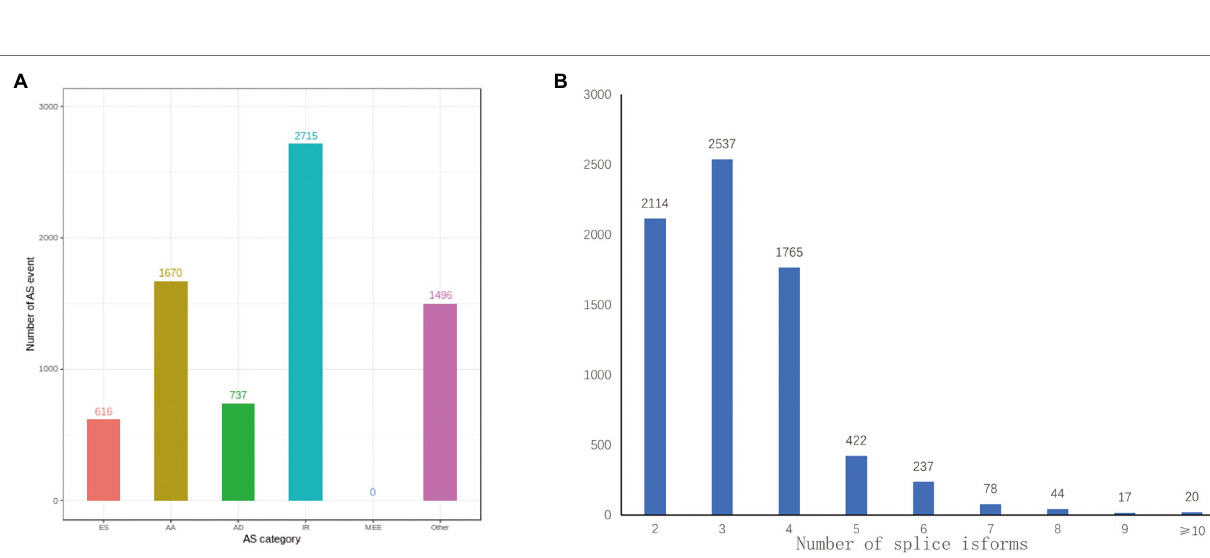
FIGURE 6 | Identification of AS events. (A) The distribution of AS events in loci detected by the PacBio Sequel platform. (B) Distribution of loci that produce two or more splice isoforms detected by the PacBio Sequel